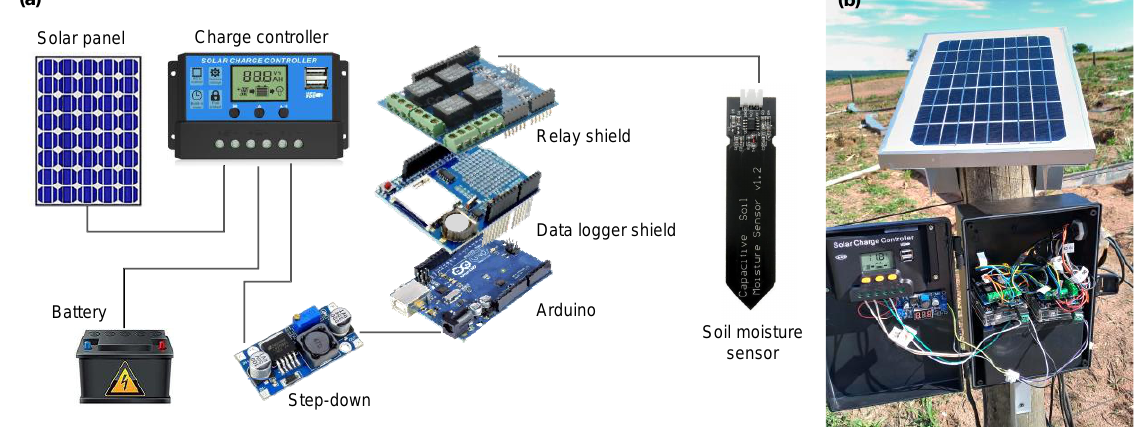
Figure 5. ( a ) Components scheme and ( b ) photo of the soil moisture monitoring station.